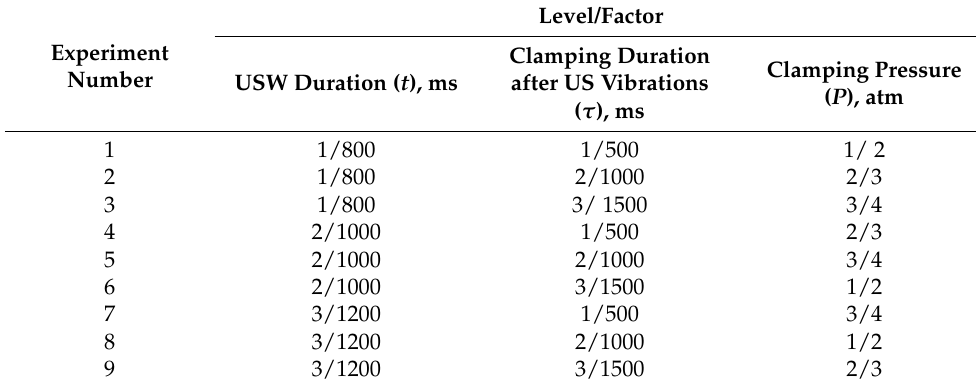
Table 1. Combination of the USW parameters and their levels (according to the Taguchi table in L9 format for a three-factor experiment).